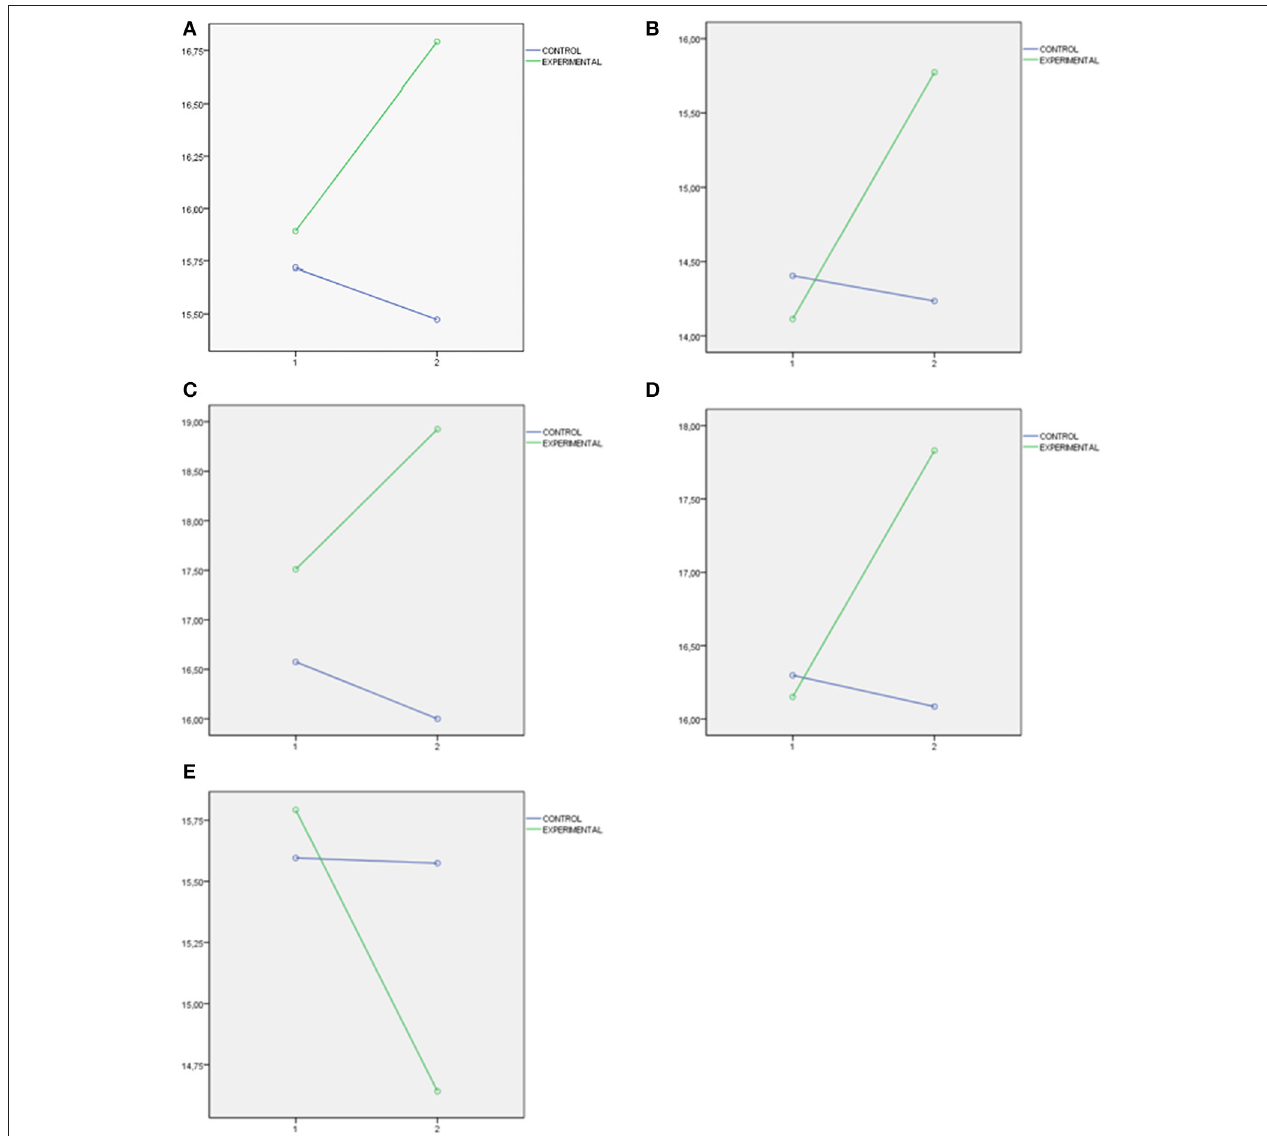
FIGURE 3 | (A) Total score EQ-i as a representation of the significant differences obtained in the set of factor of EI measure with Emotional Quotient Inventory Short EQ-i YV. (B) Intrapersonal intelligence EQ-i. (C) Intrepersonal intelligence EQ-i. (D) Stress management EQ-i. (E) Adaptation